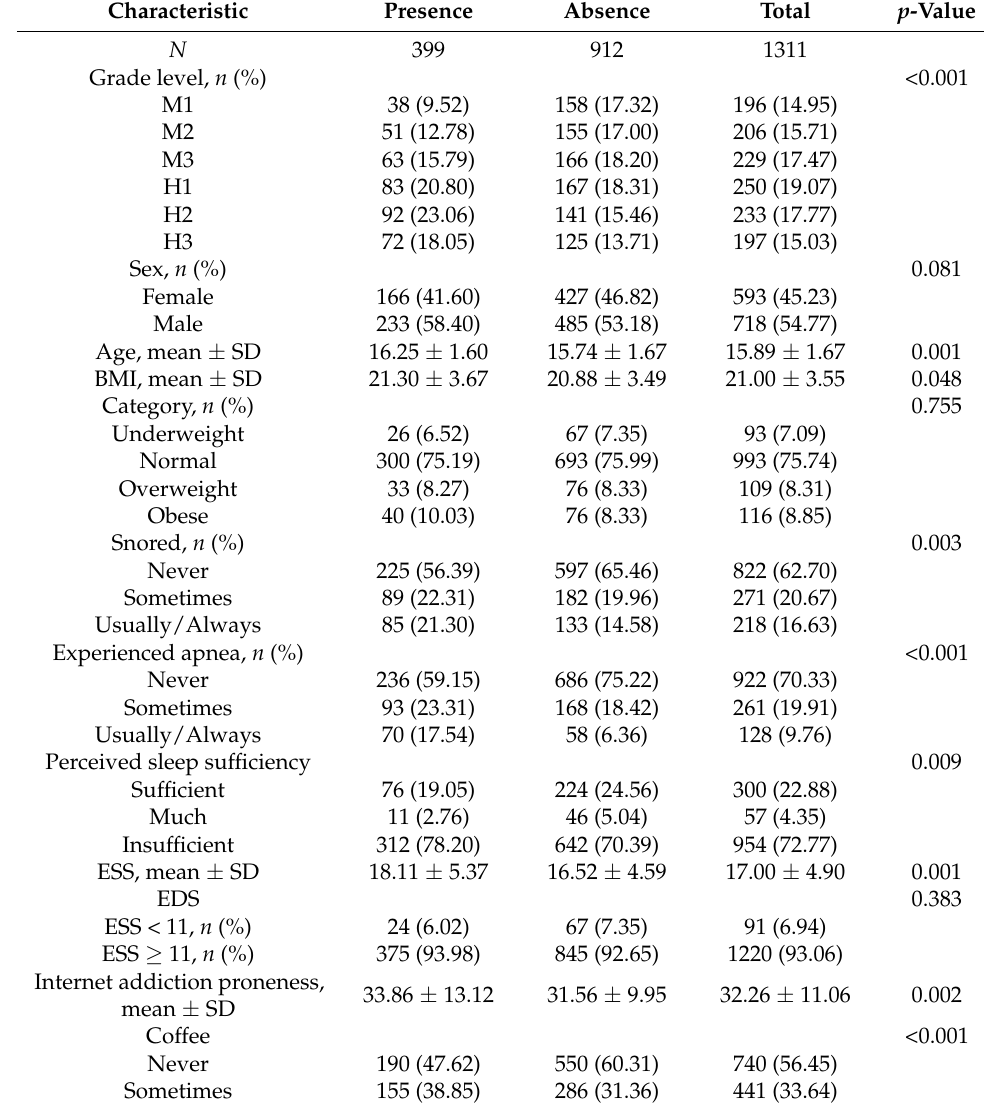
Table 2. Participants’ characteristics according to the presence of self-perceived PLMS in participants with restless legs